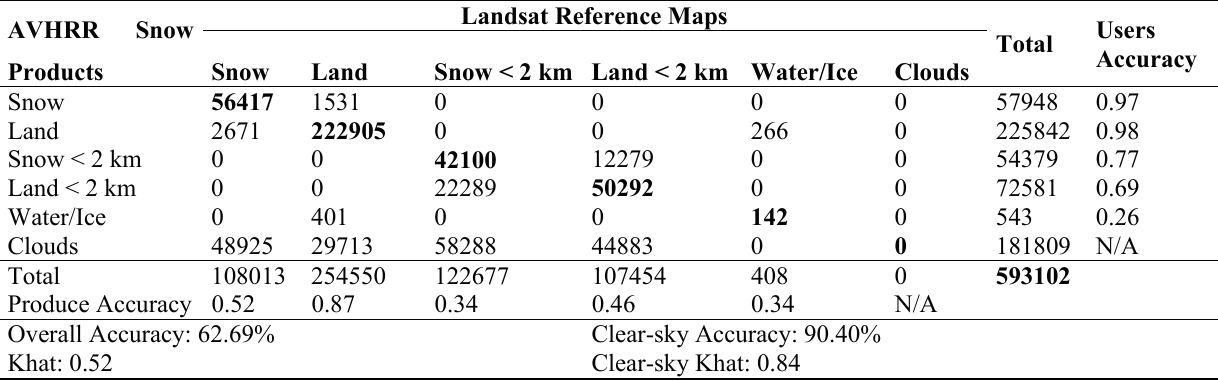
Table 4. Confusion Matrix of Landsat and the AVHRR Processing Over Land, cLoud and Ocean (APOLLO) snow